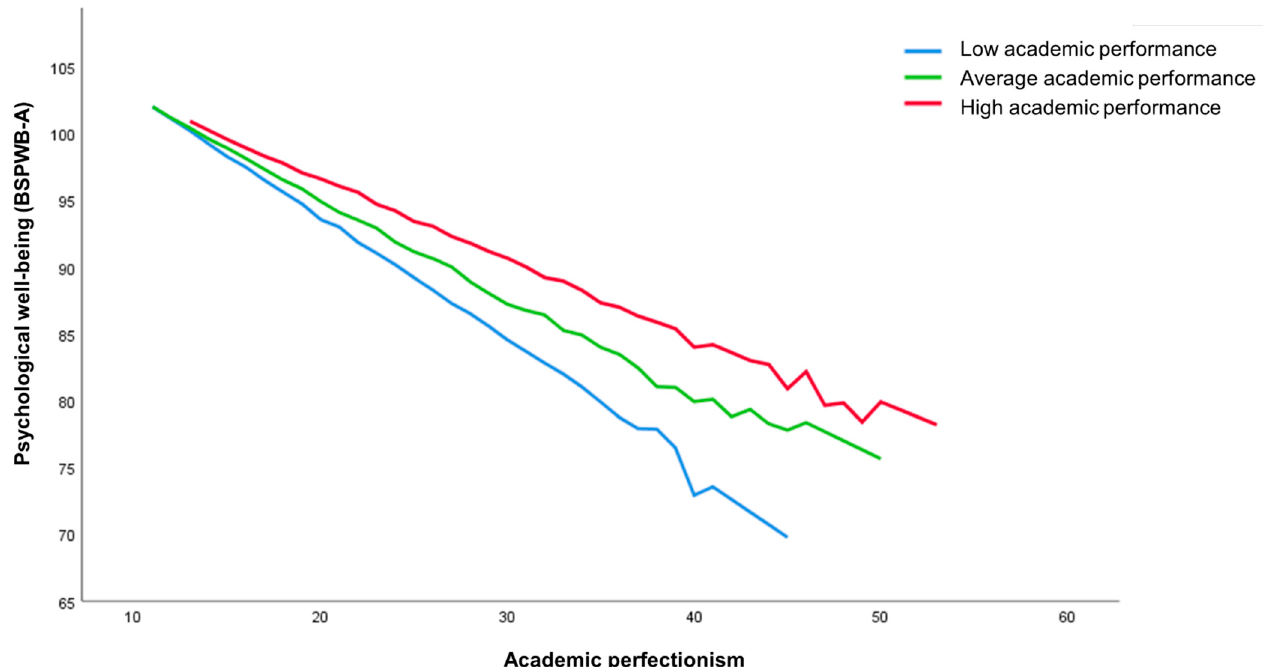
Figure 1. Academic performance (average grade) as a mediator between the level of perfectionism and psychological well-being.